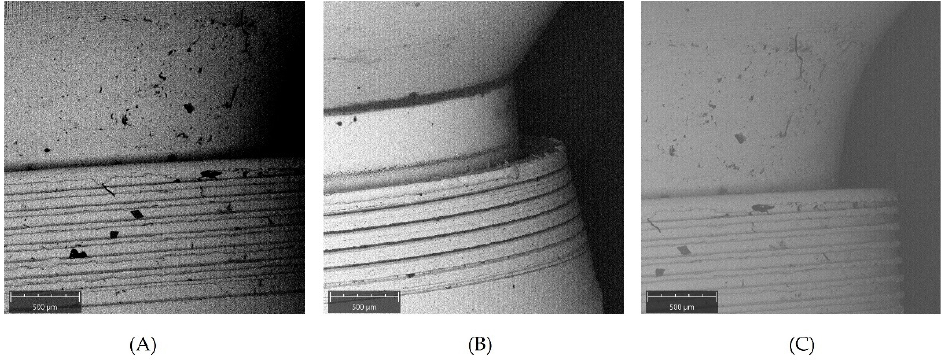
Figure 11. ( A ) SEM image of the Cone Morse 2°—Abutment with passing screw ( B ) Cone Morse 2°—Solid abutments ( C ) SEM image of the Conometric connection 18°.